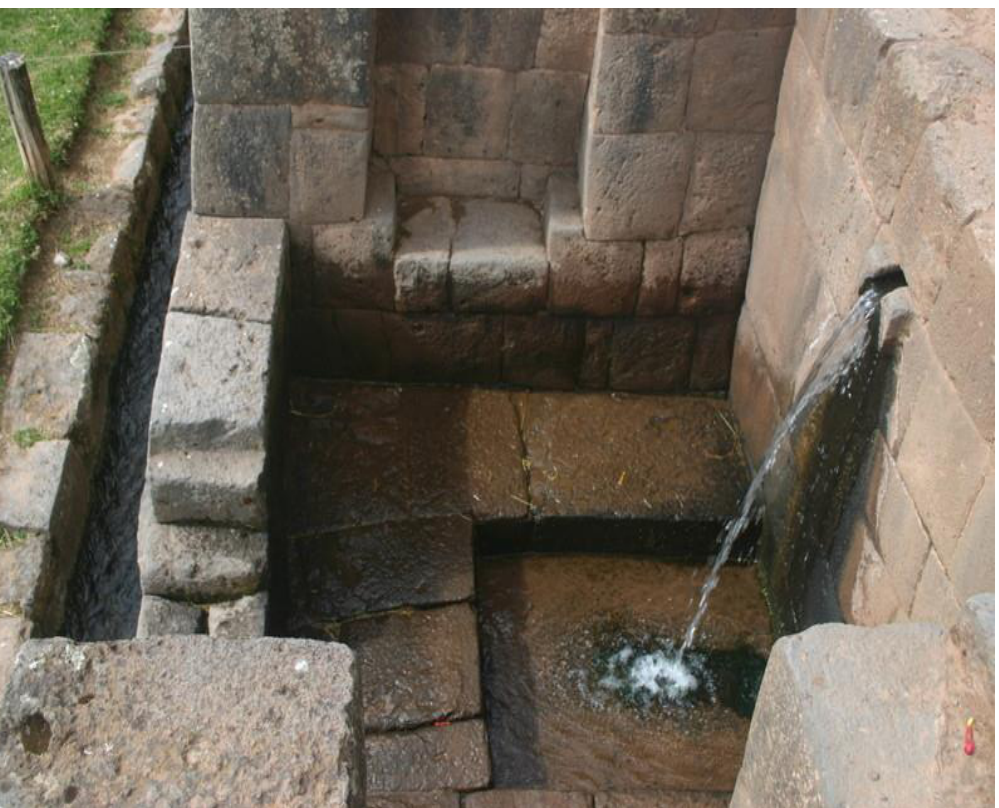
Figure 9. Spillage basin supplied by the easternmost drainage channel directing water to lower site occupation and reservoir areas. The easternmost channel is located to the right of all platforms shown in Figure 2 and is to the right of the Plaza Ceremonial shown in Figure 1. (Photo by C. Ortloff).